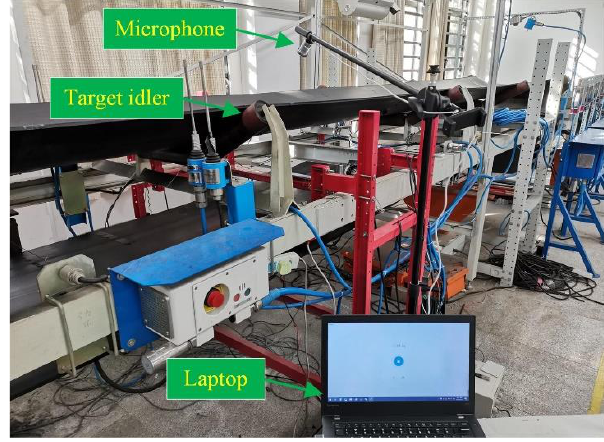
Figure 6. Experimental platform for the fault diagnosis of a belt conveyor idler. Table 1. Idler parameters.